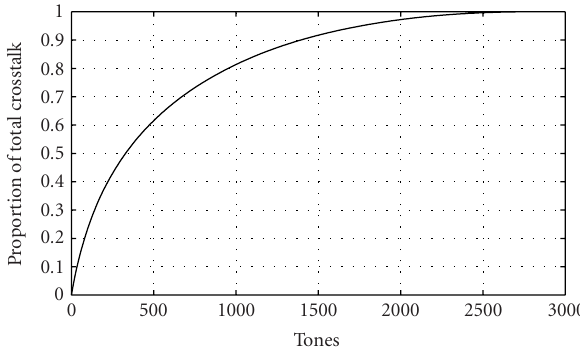
Figure 3: Proportion of crosstalk contained within i worst tones.